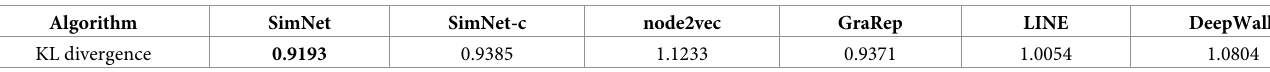
Table 4. Final KL divergence for the DBLP